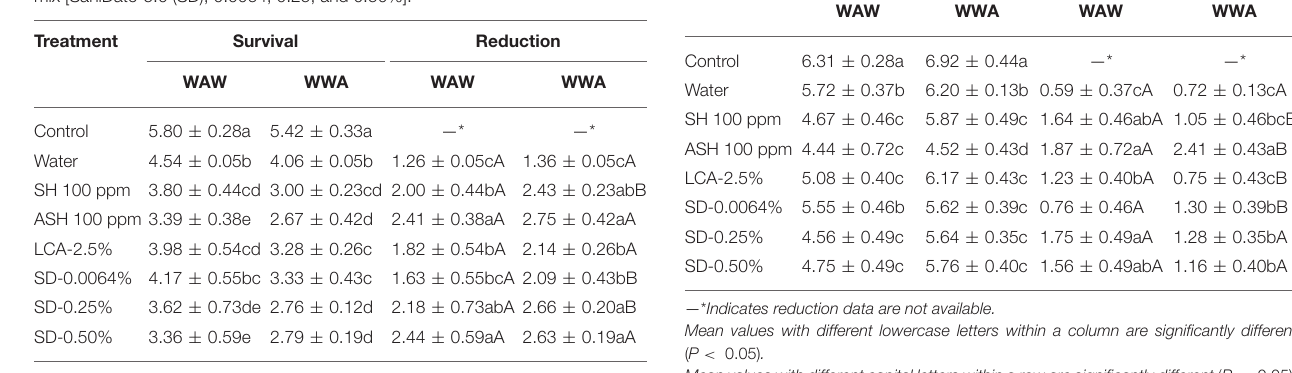
TABLE 1 | Survival and reduction of Salmonella Typhimurium and Tennessee on cucumbers [log colony-forming units (CFU)/cucumber] by triple-wash procedure water dip–antimicrobial dip–water dip (WAW) or water dip–water dip–antimicrobial dip (WWA) in water, sodium hypochlorite (SH, 100 ppm, pH 8.2), acidified SH (ASH; SH, 100 ppm, pH 6.8 adjusted by citric acid), lactic and citric acid blend (LCA, Veggiexide ® , 2.5%), and a peroxyacetic acid (PAA) and hydrogen peroxide mix [SaniDate-5.0 (SD), 0.0064, 0.25, and 0.50%].